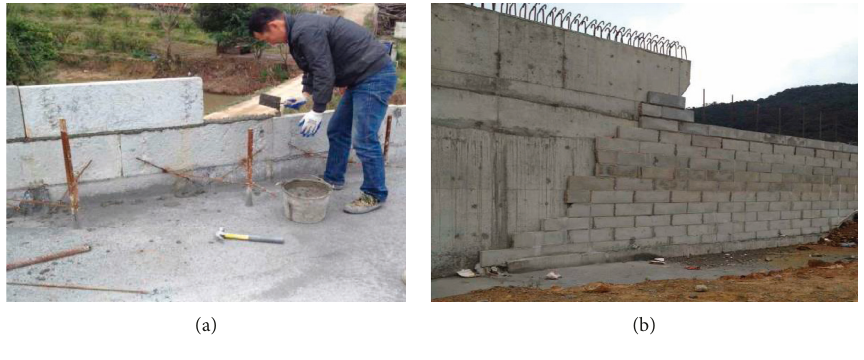
Figure 7: (a, b) Cement panel